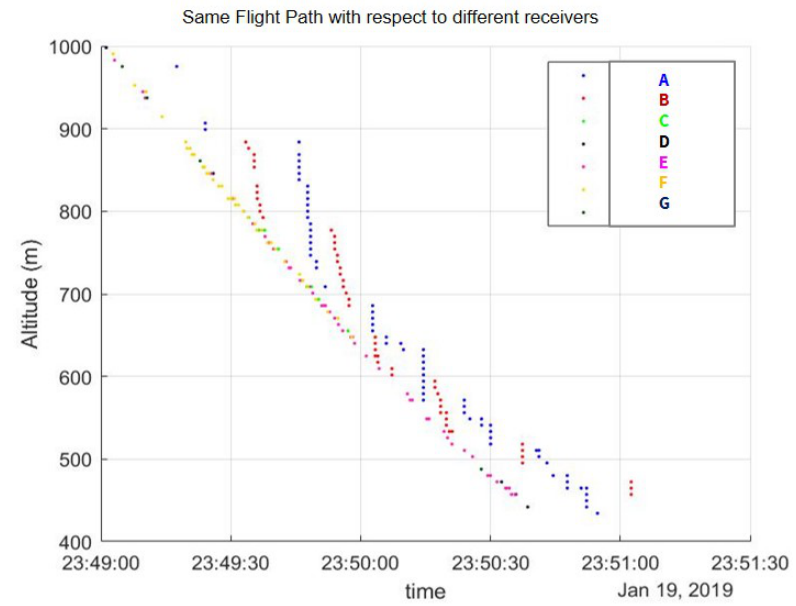
Figure 8. Time versus altitude plot of same flight with respect to different